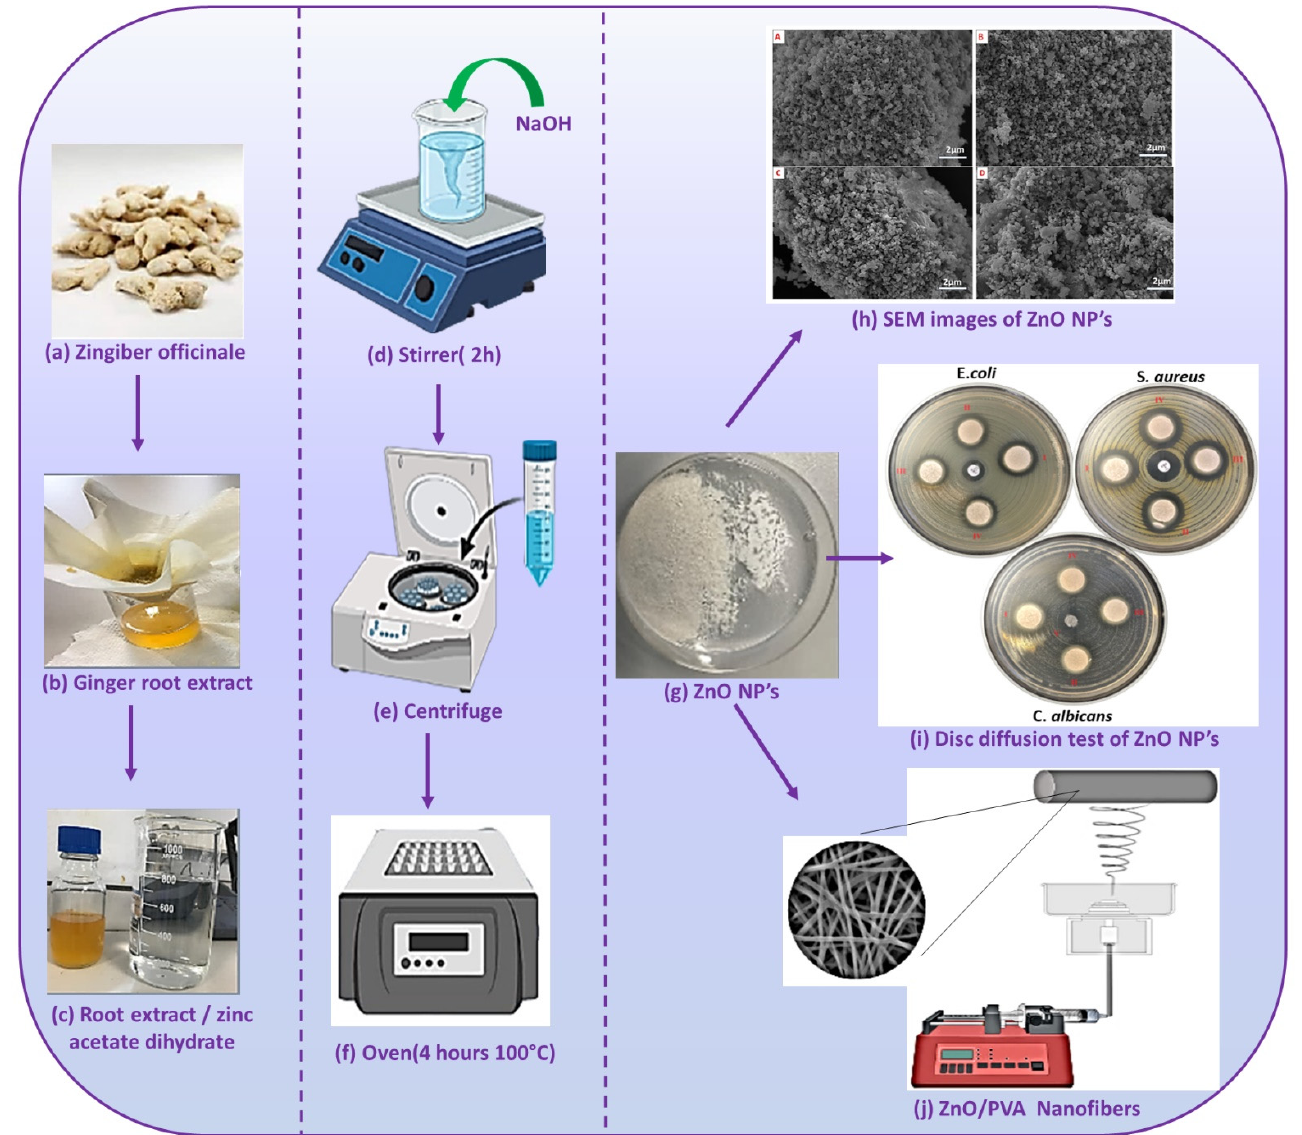
Figure 1. Production of ZnO NP by green synthesis method using ginger roots, SEM images of ZnO NP and antimicrobial result, and electrospinning of nanofibers by mixing zinc oxide nanoparticles with PVA polymer. ( a ) Cleaned and dried gingers; ( b ) filtered ginger extract, ( c ) mixing the ginger extract with zinc acetate dihydrate dissolved in water; ( d ) mixed in a mixer for 2 h, ( e ) cen- trifuge and discard the supernatant; ( f ) dried in the oven for 4 h; ( g ) the last version of ZnO NP; ( h ) SEM images of the obtained ZnO NP were taken; ( i ) the antimicrobial effect of the obtained ZnO NP was examined; ( j ) the obtained ZnO NP are mixed with PVA and nanofiber is obtained by electrospinning